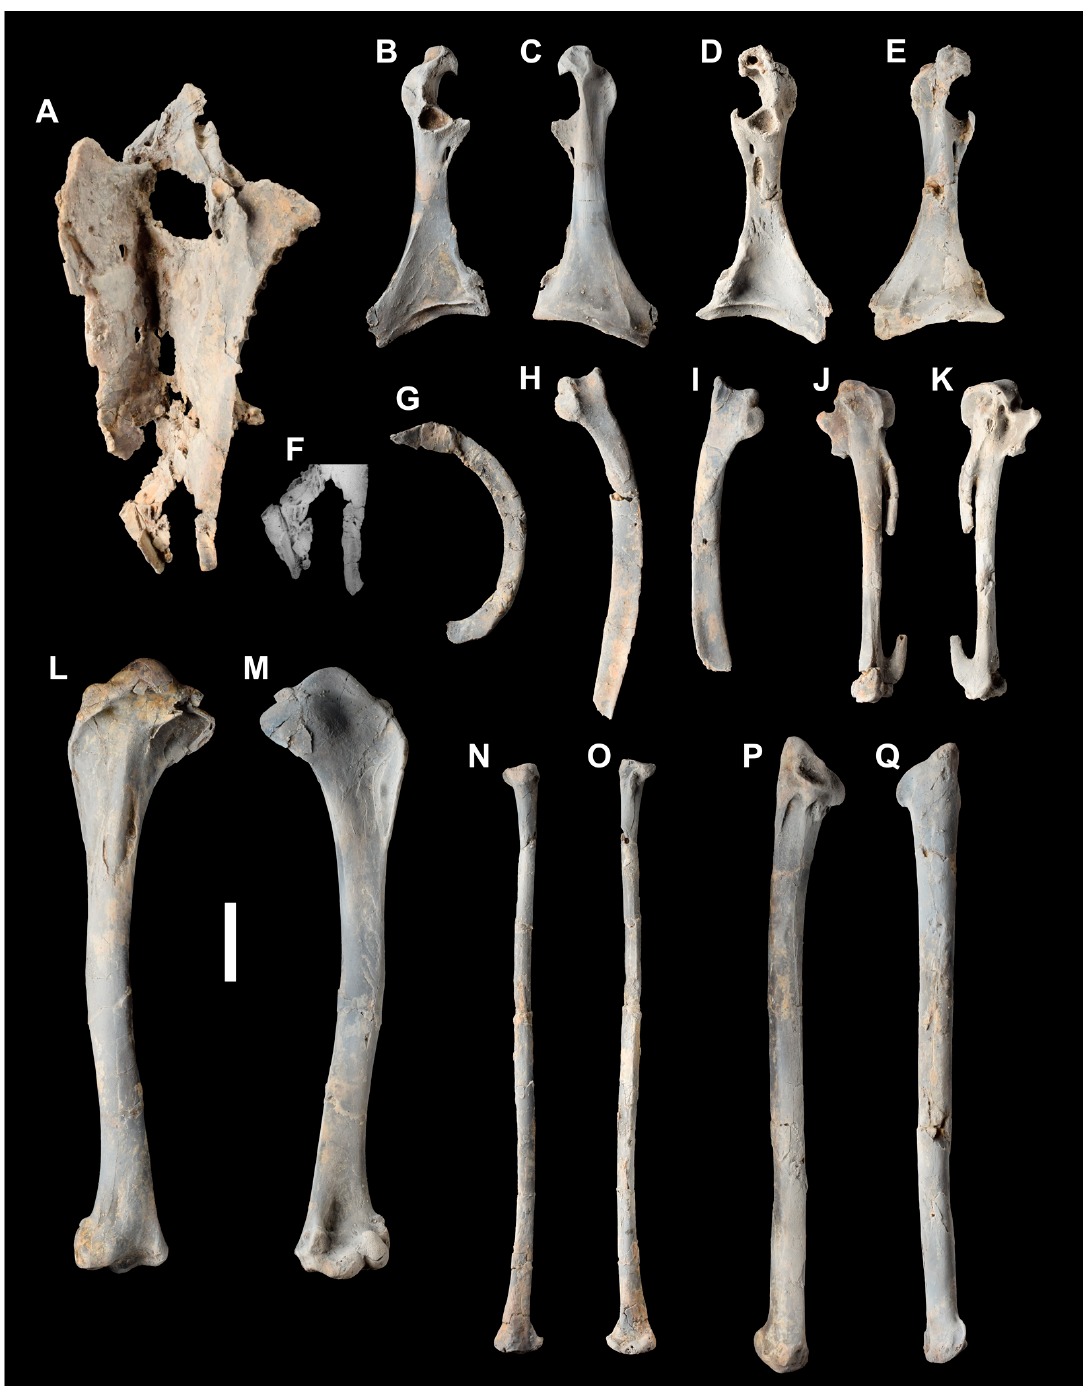
Figure 2. Holotype of Anachronornis anhimops nov. gen. et sp. (USNM 496700): sternum left ventrolateral ( A ), inset of caudal margin prior to damage to lateral trabecula ( F ); coracoids, left dorsal ( B ), left ventral ( C ), right dorsal ( D ), right ventral ( E ), right lateral clavicle ( G ); scapulae, left lateral ( H ), right lateral ( I ); left carpometacarpus, dorsal ( J ), ventral ( K ); left humerus, caudal ( L ), cranial ( M ); left radius, cranial ( N ), caudal ( O ); left ulna, ventral ( P ), dorsal ( Q ). All coated with ammonium hydroxide. Scale bar 1 cm.